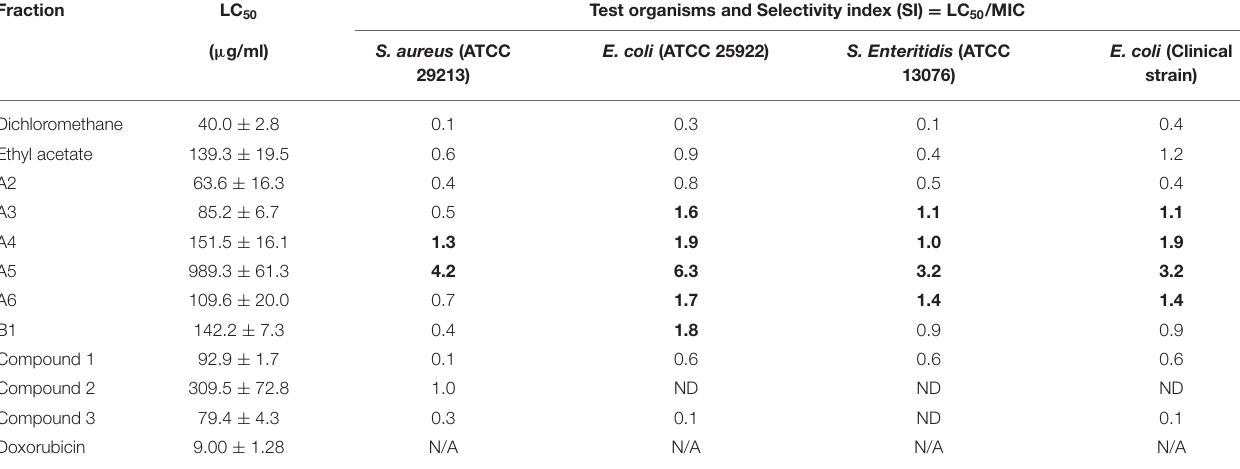
TABLE 2 | Cytotoxicity (LC 50 values) and selective index of the S. singueana fractions with respect to antibacterial activity.